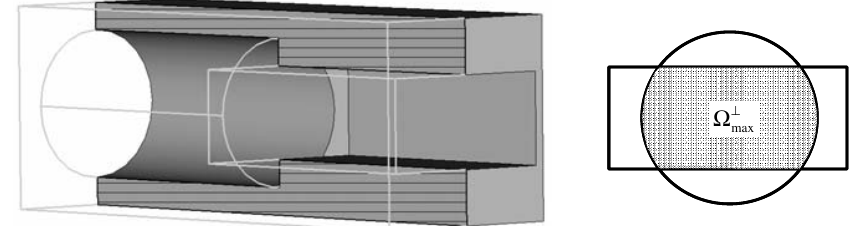
FIG. 3. Round to rectangular transition and the maximal area for wake potential